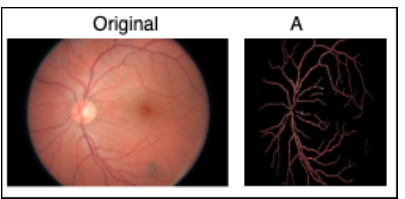
Figure 5. Region of Interest; (A) blood vessel segmentation of the original image